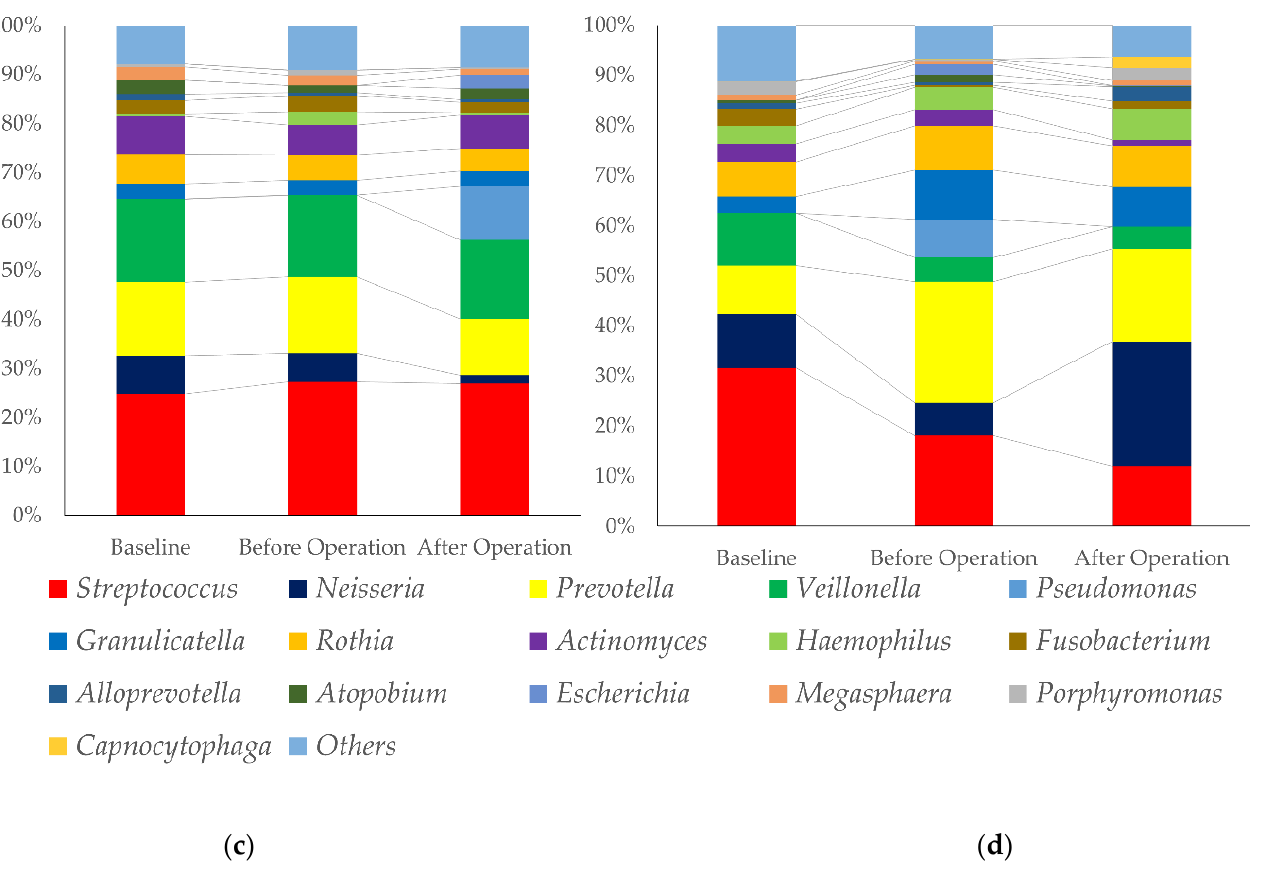
Figure 1. Composition of oral microbiome of the patients with or without fever after a cancer operation. ( a ): Phylum level changes in oral microbiome, patients with pneumonia after a cancer operation, ( b ): Phylum level changes in oral microbiome, control, ( c ): Genius level changes in oral microbiome, patients with pneumonia after a cancer operation, and ( d ): Genius level changes in oral microbiome, control.